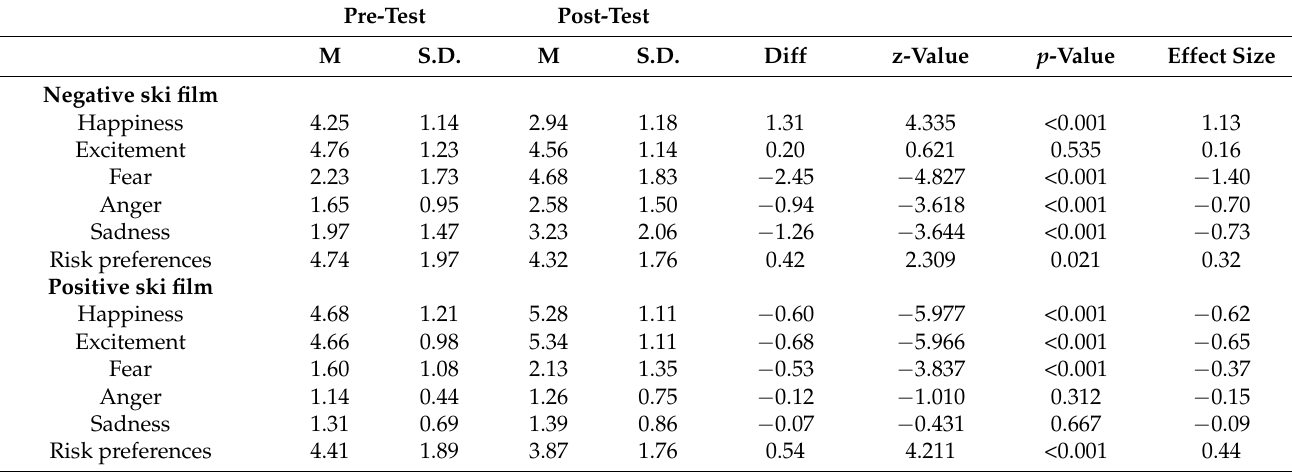
Table 5. Within-subject comparisons. Wilcoxon signed rank